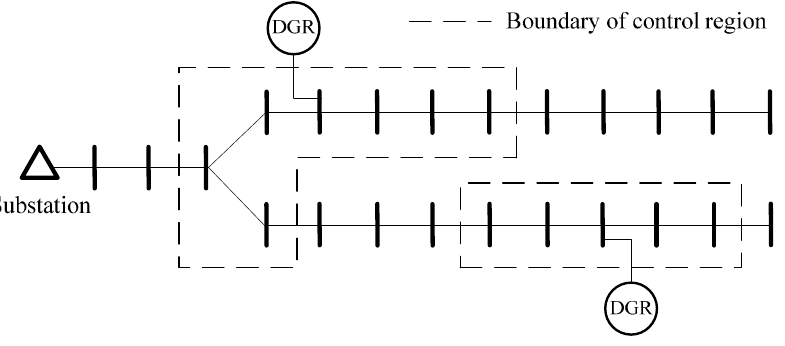
Figure 1. A simple example of control region delimitation.